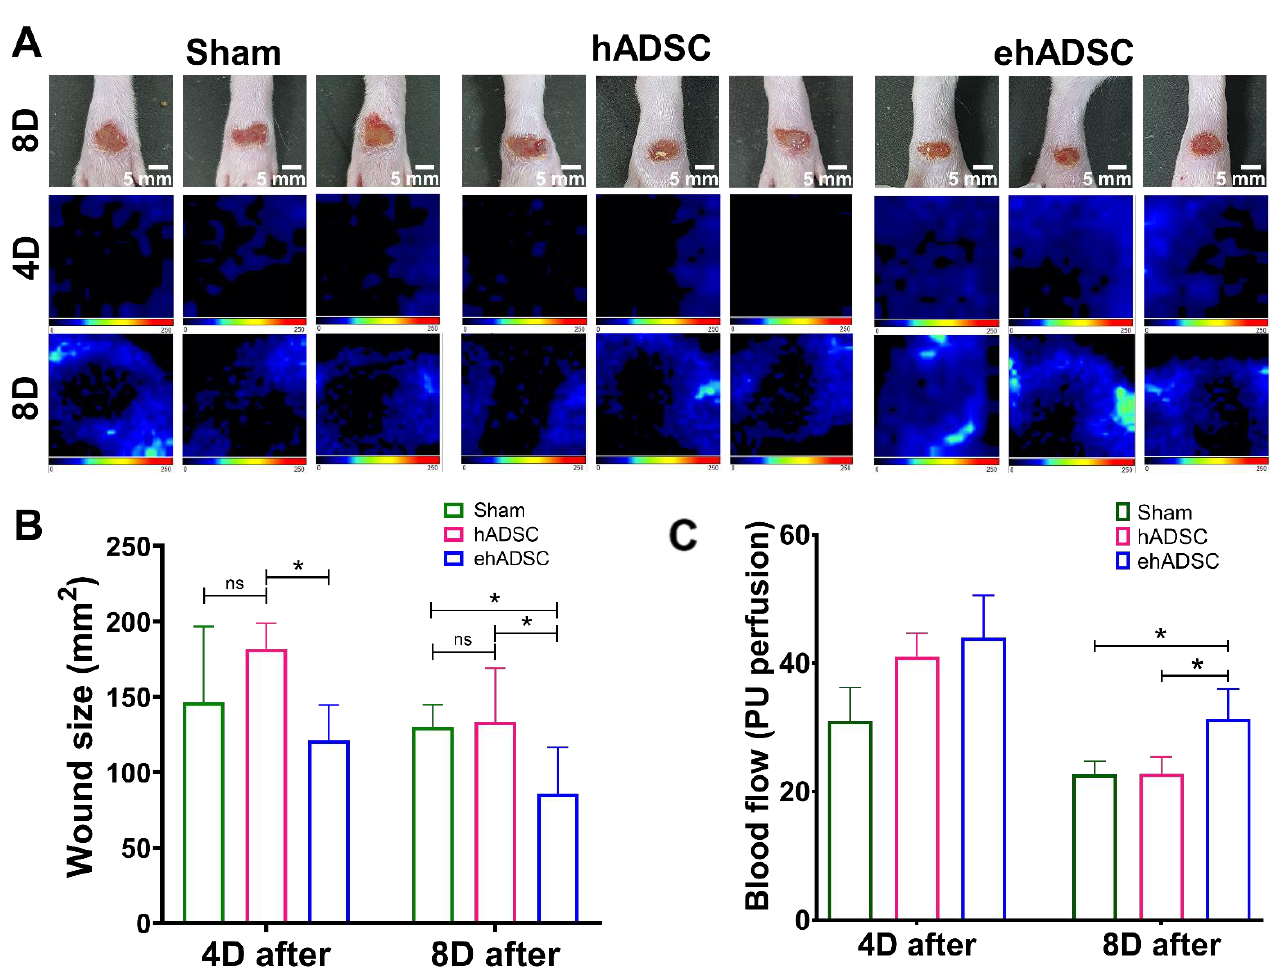
Figure 4. Wound closure and blood flow. ( A ) Wound size and Doppler evaluations were performed at 4 and 8 days after wound formation ADSCs injection. ( B ) At 4 days, a significant difference in wound size was observed between the hADSC and ehADSC groups. At 8 days, wounds in the ehADSC group were still significantly different (smaller) compared to others. ( C ) Blood flow 4 and 8 days after the ADSC injection are shown. There was no significant difference in the blood flow among the groups on day 4. On day 8, the ehADSC group exhibited a significantly increased blood flow compared to others. (* p < 0.05; n.s., not significant).